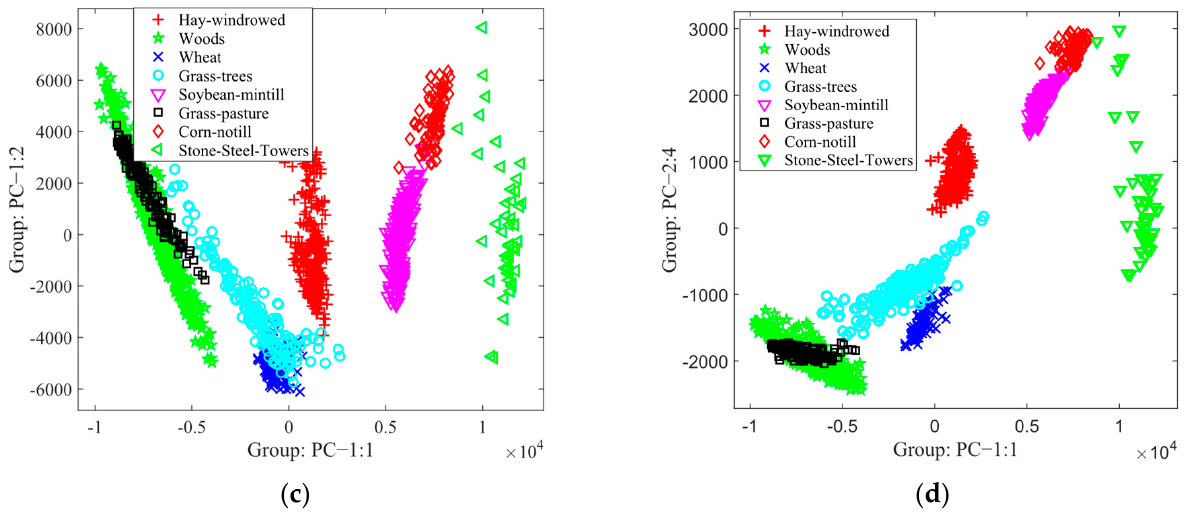
Figure 7. Scatterplots for different methods for the Indian Pines dataset: ( a ) PCA, ( b ) SPCA, ( c ) BgPCA, and ( d ) BgPCA-NMI.